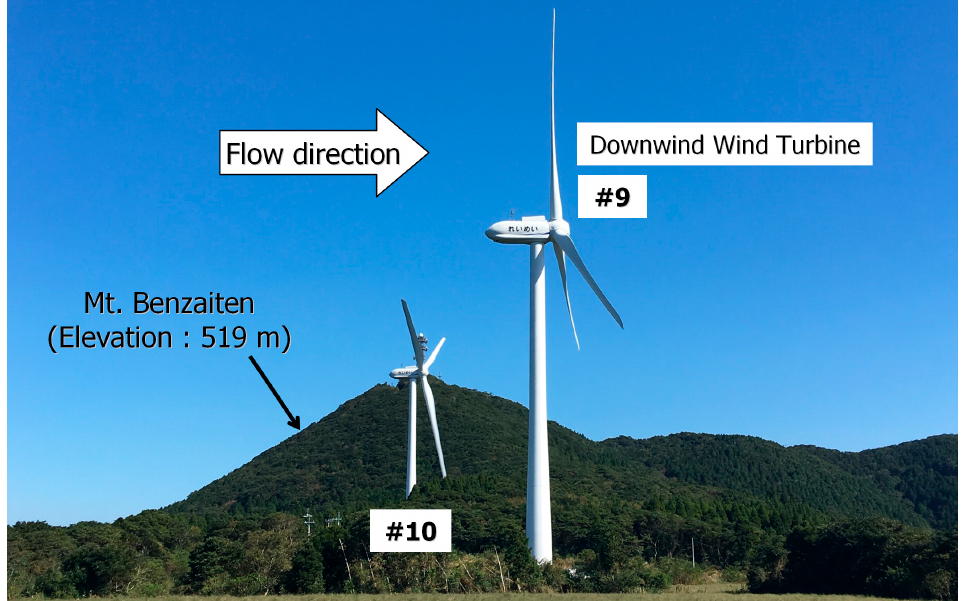
Figure 2. Photo of wind turbine #10.